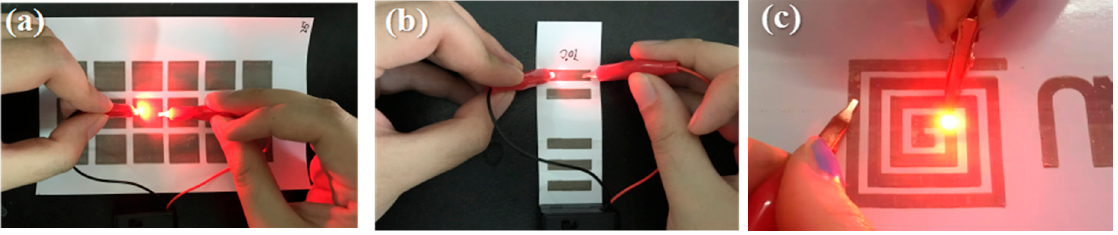
Figure 10. The simple conductivity test of printed Ag patterns: ( a ) Square; ( b ) Rectangle; ( c ) Spiral.